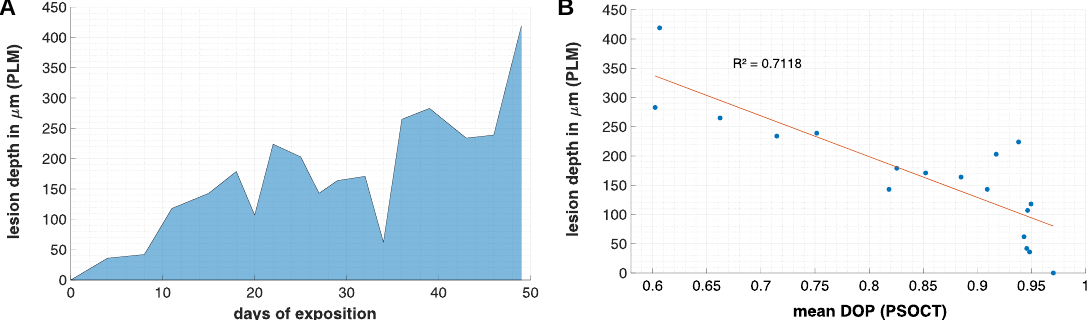
Figure 4. ( A ) Measured lesion depth by PLM over the duration of acid exposition, i.e., stage of demineralization. ( B ) Scatter plot of the measured lesion depth by PLM and mean DOP at the central region of interest (ROI) of the slab. Linear regression (red line) shows a coefficient of determination of R 2 =